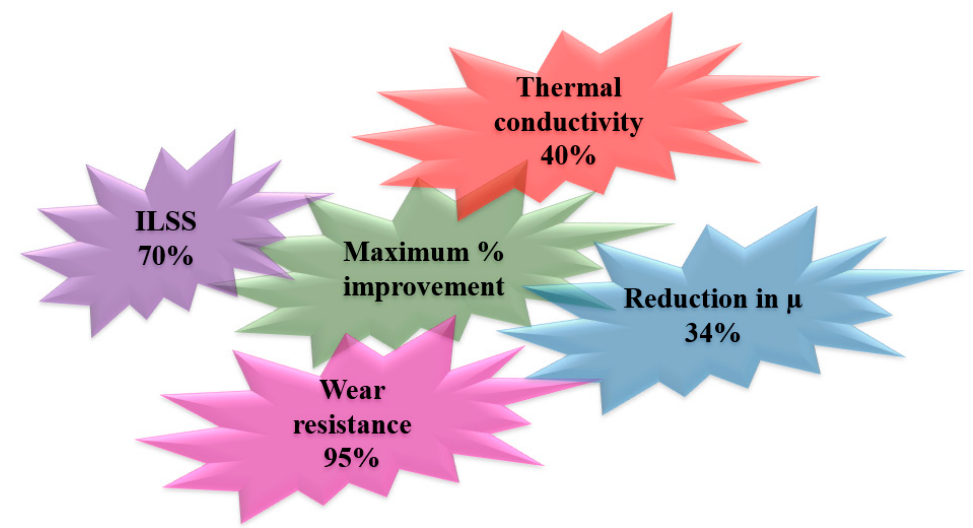
Figure 16. Performance enhancement due to in-situ grown Ag NPs on carbon fabric